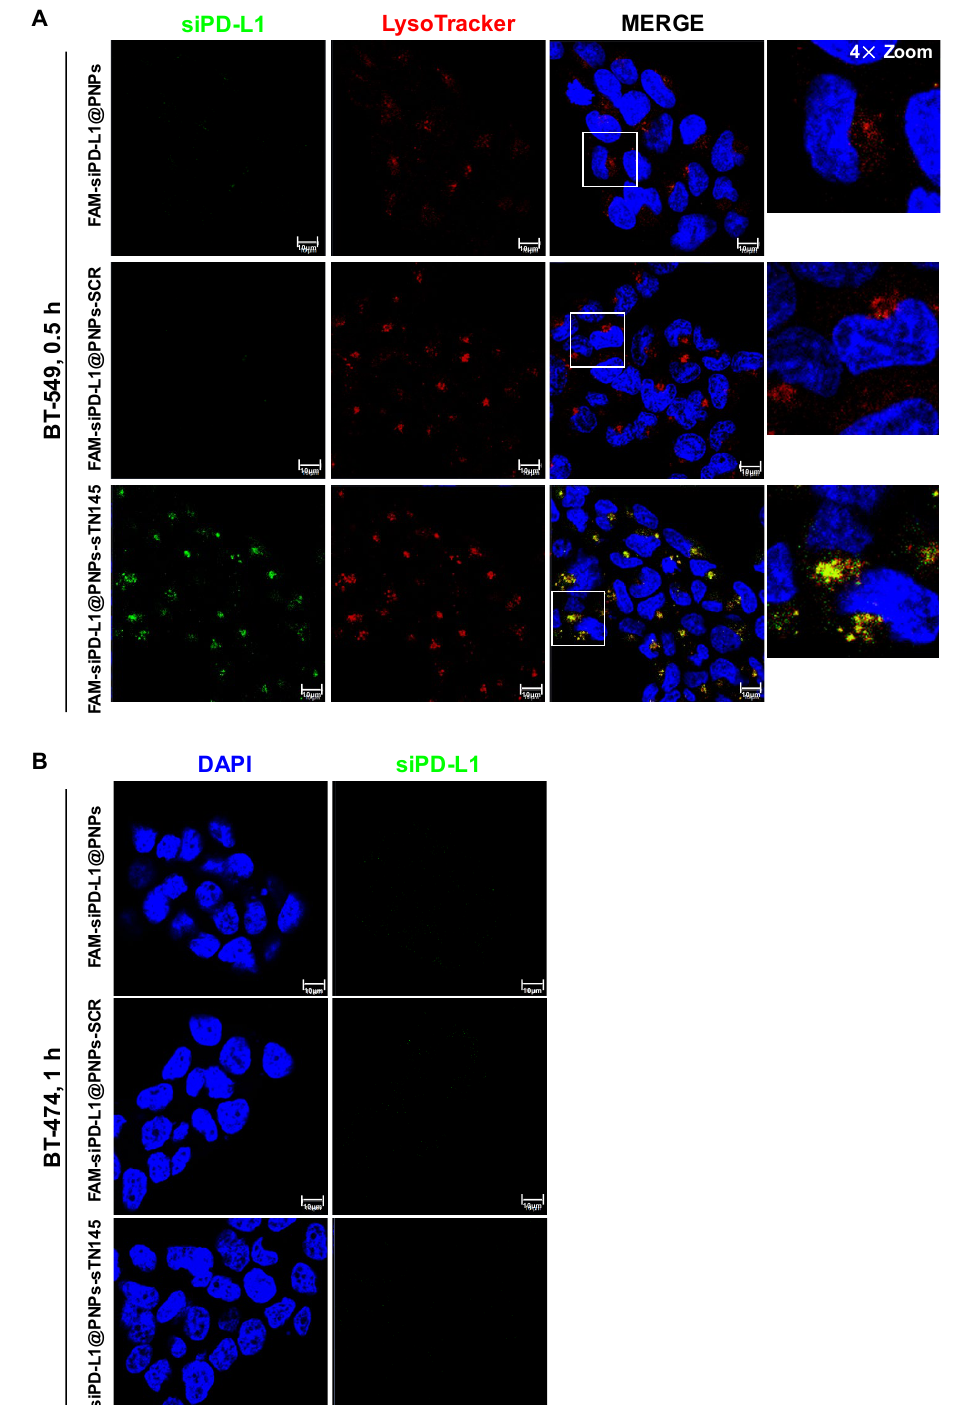
Figure 3. FAM-siPD-L1@PNPs-sTN145 are effectively taken up by TNBC BT-549 cells. ( A ) Repre- sentative confocal images of BT-549 cells incubated for 0.5 h at 37 ◦ C with FAM-siPD-L1@PNPs, FAM-siPD-L1@PNPs-SCR, or FAM-siPD-L1@PNPs-sTN145 after live-staining with LysoTracker Red for endosomes’ visualization. FAM-siPD-L1, LysoTracker, and nuclei are visualized in green, red,